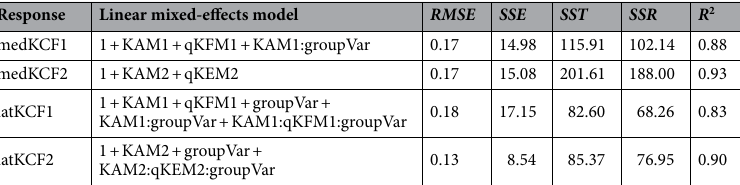
Table 5. Statistical summary of the leave one out cross-validation of the linear mixed-effects models between the internal knee joint contact forces and external knee joint moments for the complete dataset (patient and typically developed healthy control group). medKCF1/medKCF2: max. value in the first/second half of stance of the medial knee joint contact force [BW]; latKCF1/latKCF2: max. value in the first/second half of stance of the lateral knee joint contact force [BW]; KAM1/KAM2: max. value in the first/second half of stance of the external knee adduction moment [Nm/kg]; qKFM1/qKEM2: squared maximal/minimal value in the first/ second half of stance of the external knee flexion/extension moment (KFM1, KEM2; [Nm/kg]); RMSE : root mean squared error [BW]; SST: sum of squares total; SSR : sum of squares regression; SSE : sum of squares error.